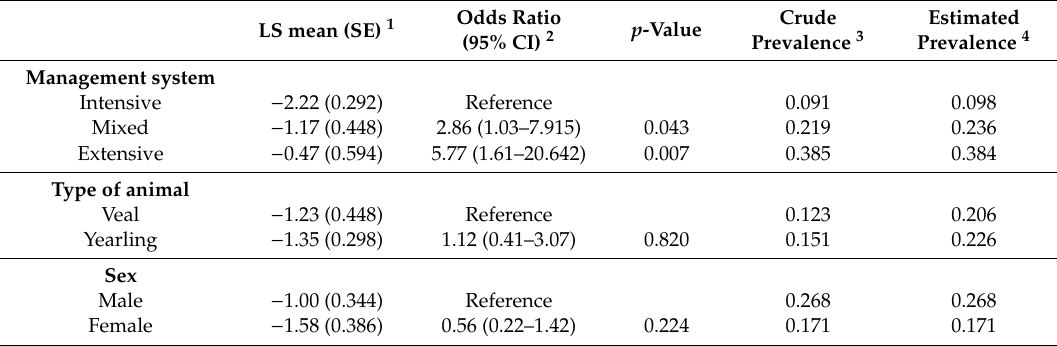
Figure 2. Acute fibrinous pneumonia. ( A ). Swollen, firm and well-demarcated cranioventral areas with vascular signs, accompanied by deposits of fibrin on the pleural surface. Haematoxylin-eosin staining (H-E). ( B ). Histologically, neutrophils, macrophages and large amounts of fibrin casts are present in the alveolar spaces with small foci of coagulative necrosis. Table 3. Parameter estimates of the model predicting log odds of type of pneumonia (log-probability of acute fibrinous /probability of chronic pneumonia) and crude observed and estimated prevalence of acute fibrinous pneumonia.